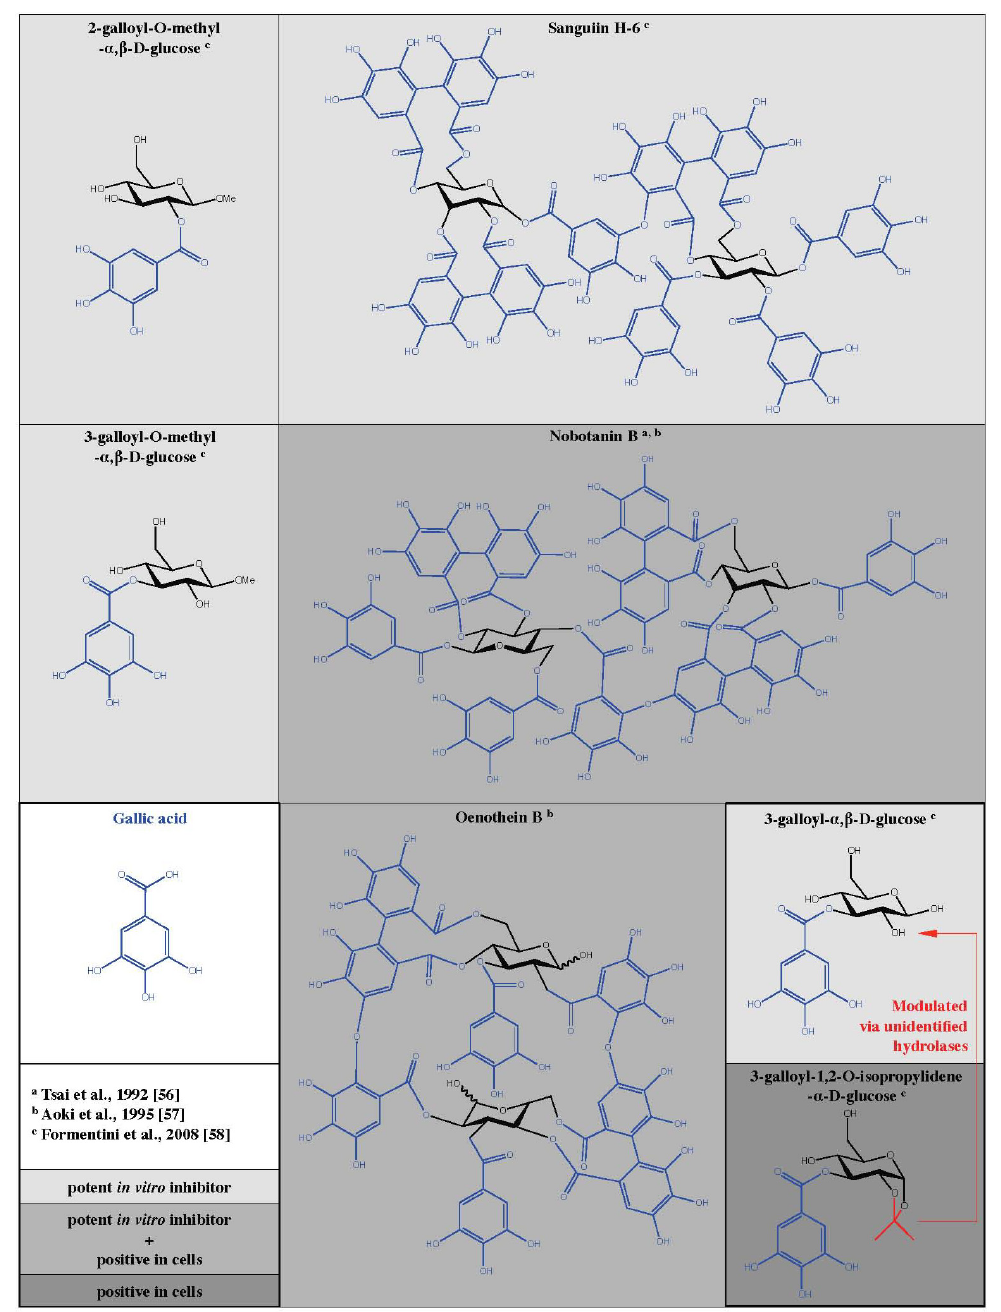
Figure 2. Chemical structures of galloyl derivates tested as PARG inhibitors with efficiency in cells and/or in vitro